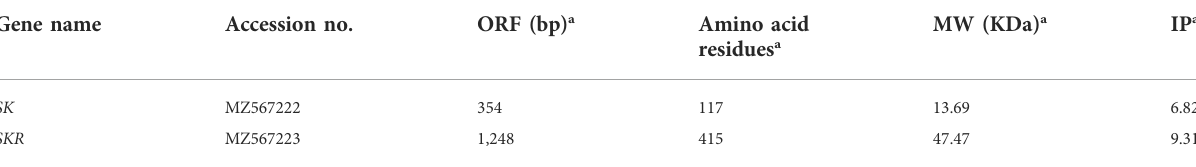
TABLE 1 Physicochemical properties of putative D. armandi SK and SKR